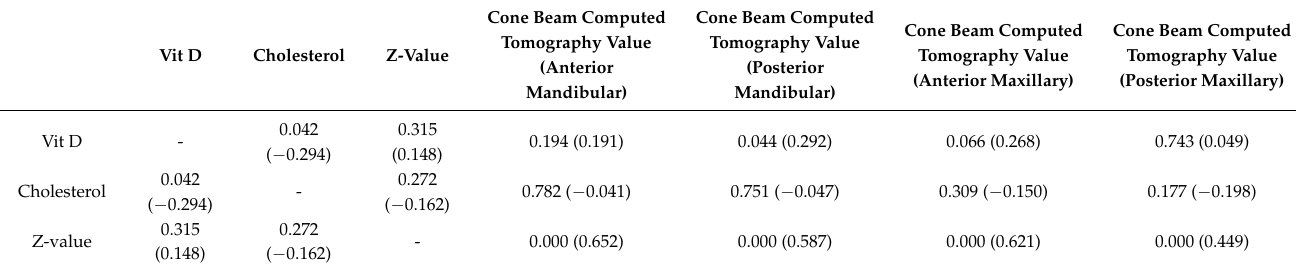
Table 6. Correlation analysis of parameters of the case